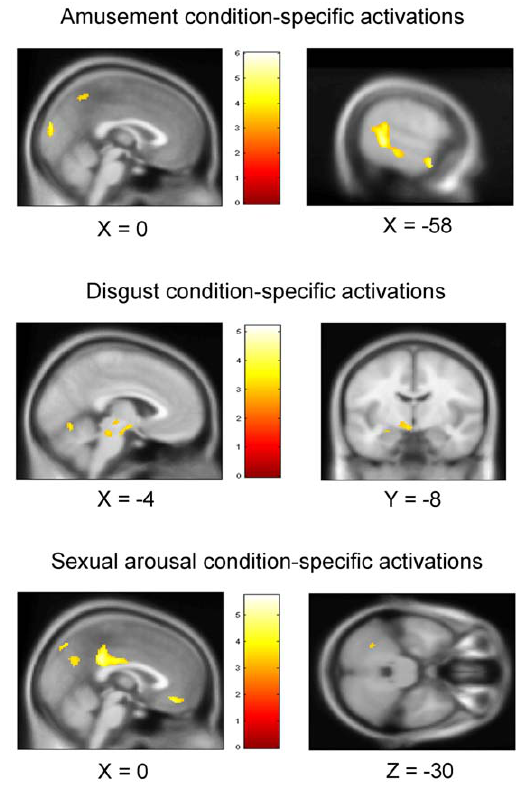
Figure 5. Sagittal, coronal, and/or axial slices across the main areas of supra-threshold activated areas for the ‘Amusement condition-specific’, ‘Disgust condition-specific’, and ‘Sexual arousal condition-specific’ contrasts. Slices were selected so as to show most involved areas. Amusement-specific temporal, medial occipital and precuneus areas are shown on top. Disgust condition- specific periaqueductal, posterior pons, left amygdala, left hypothala- mus, and cerebellar areas are shown in the middle and Sexual arousal- condition-specific medial prefrontal, posterior cingulate, cerebellar, and precuneus regions are shown at the bottom.